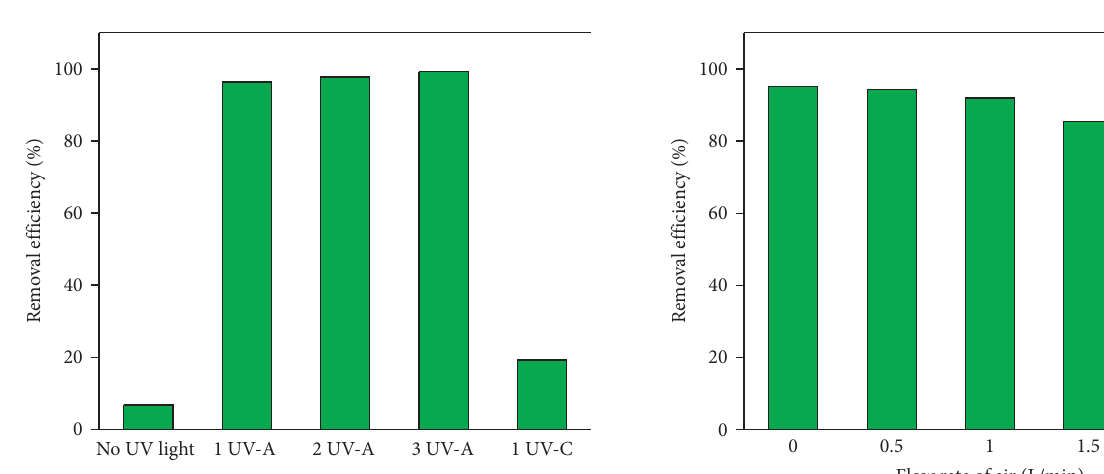
Figure 6: Effects of the irradiation wavelength and the irradiation intensity (pH 8, 0.15g TNTs, 90min of reaction time).